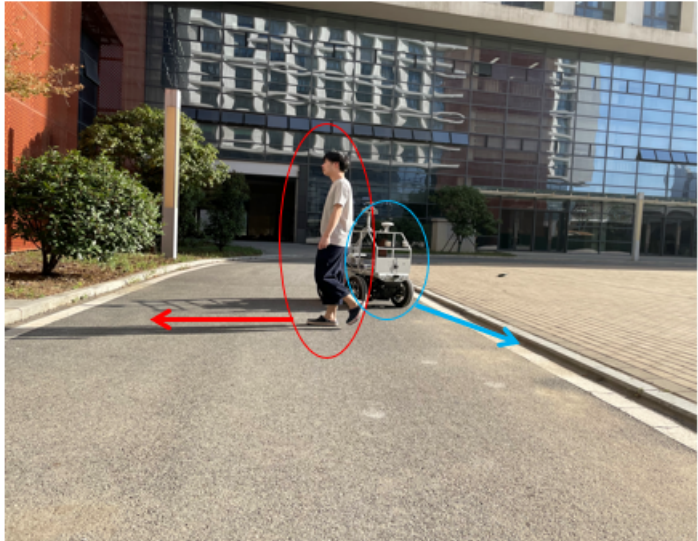
Figure 20. The stage when the vehicle and pedestrian approach each other. As shown in Figure 21, since the local planner only re-plans in a local area, after bypassing pedestrians, the vehicle will still return to the path planned by the middle planner to continue driving. When the feasibility of the middle planning path cannot be guaranteed, the local optimal path is used as the current travel path.